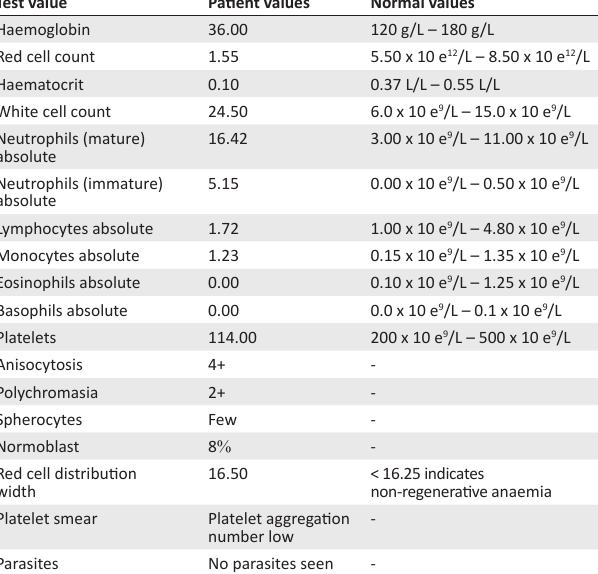
TABLE 2: Haematological findings.